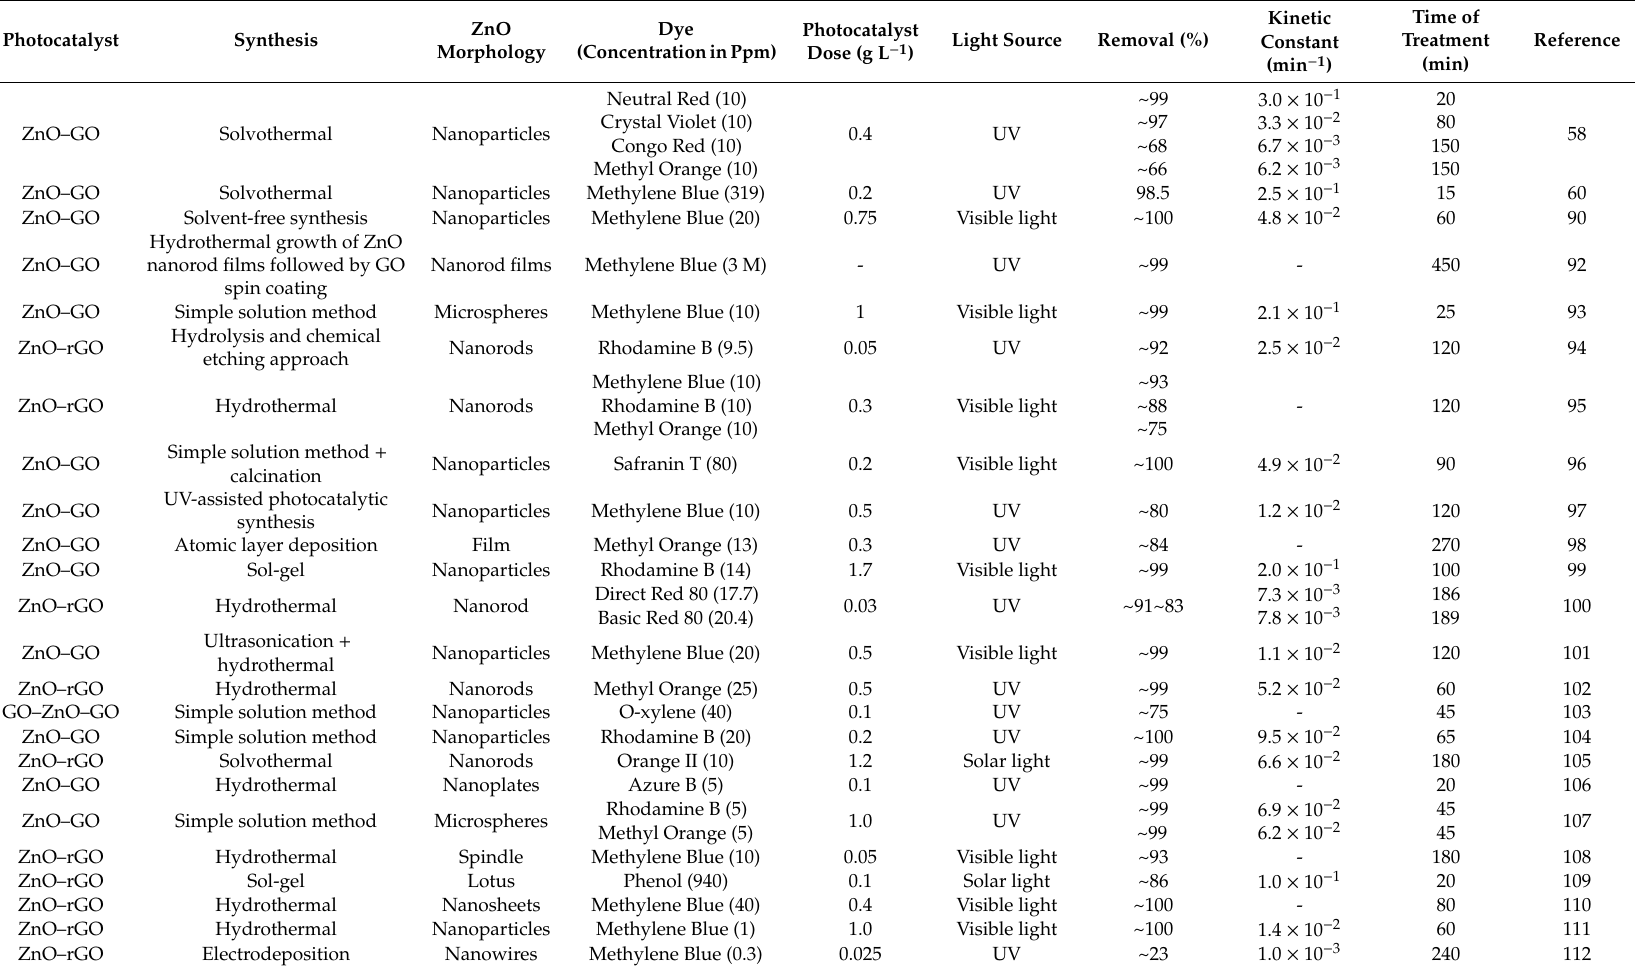
Table 1. Comparison of the synthesis, photocatalytic conditions, and photocatalytic performance of ZnO–rGO and ZnO–graphene oxide (GO) nanocomposites photocatalysts in the photo-oxidation of organic